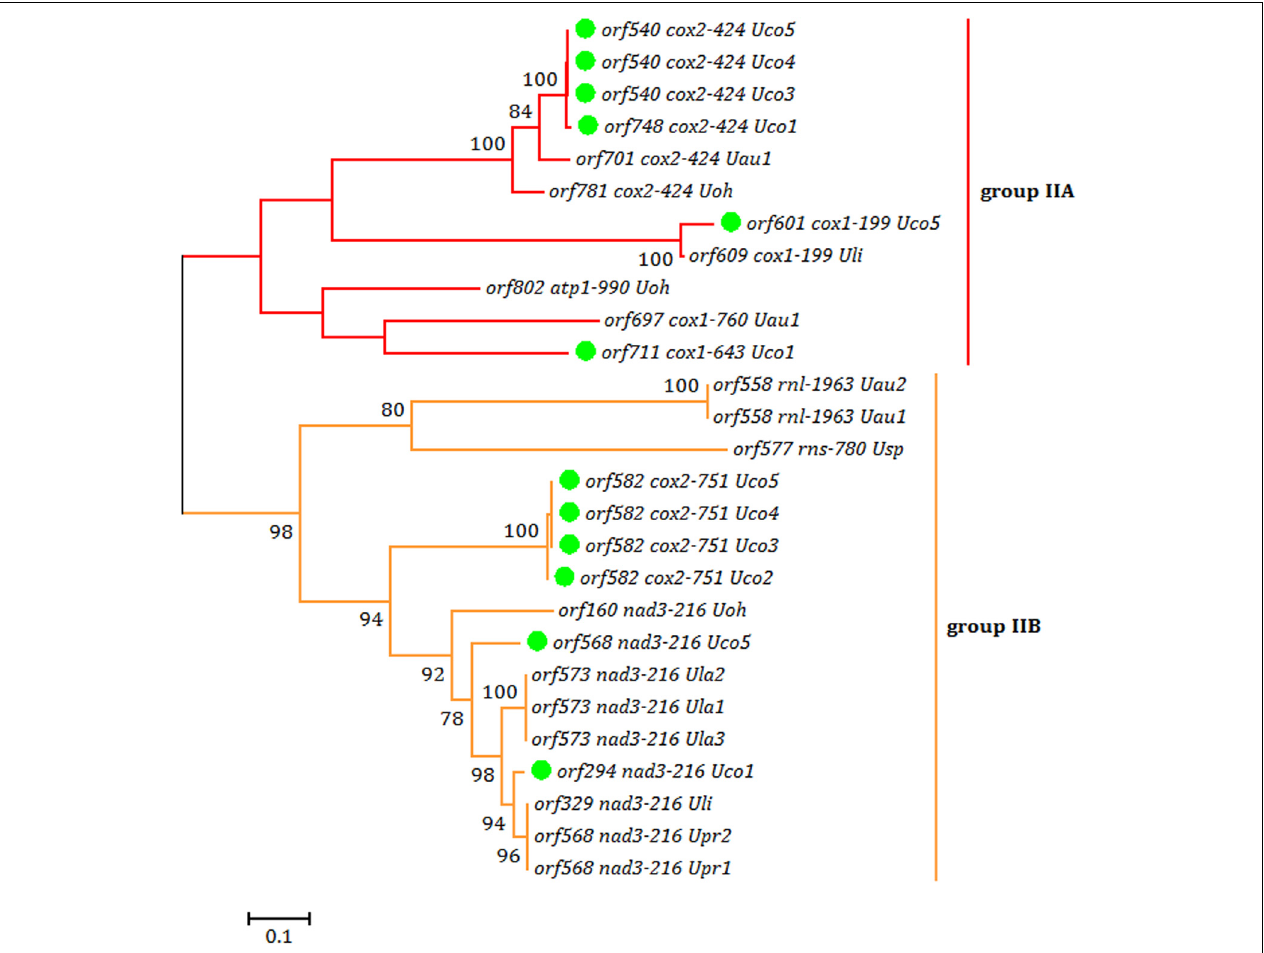
FIGURE 5 | Phylogenetic tree based on Maximum Likelihood (ML) analysis of amino acid (aa) sequences of 27 reverse transcriptase (RT) domains from intronic orf s in group IIA and IIB introns. The ML analysis was conducted with 1,000 bootstrap replicates using MEGA 7.0. Branch lengths were proportional to the amount of sequence change, which were indicated by the scale bar below the